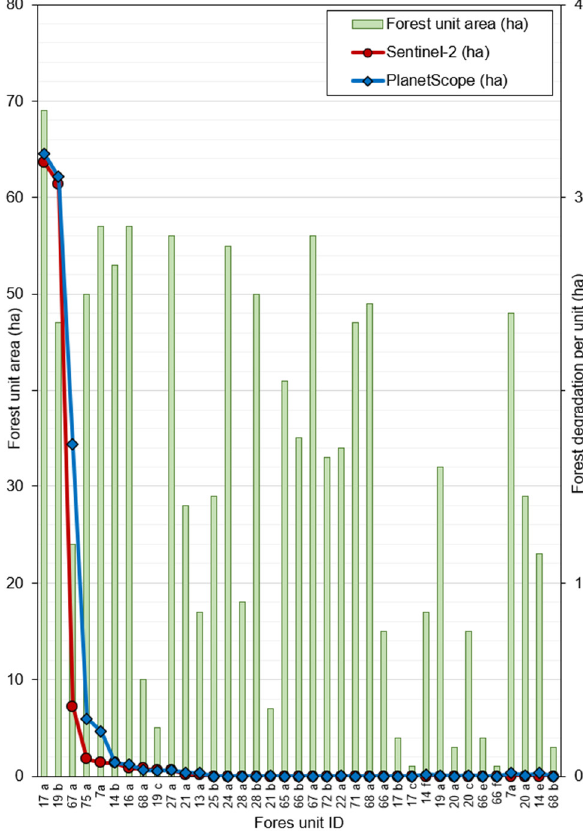
Figure 7. Forest degradation monitoring and analysis of two management units (Javornik and Ćorkovača-Karlice) by proposed automatically forest degradation mapping approach based on S2 10-m imagery and 3-m forest degradation maps obtained manually from PlanetScope